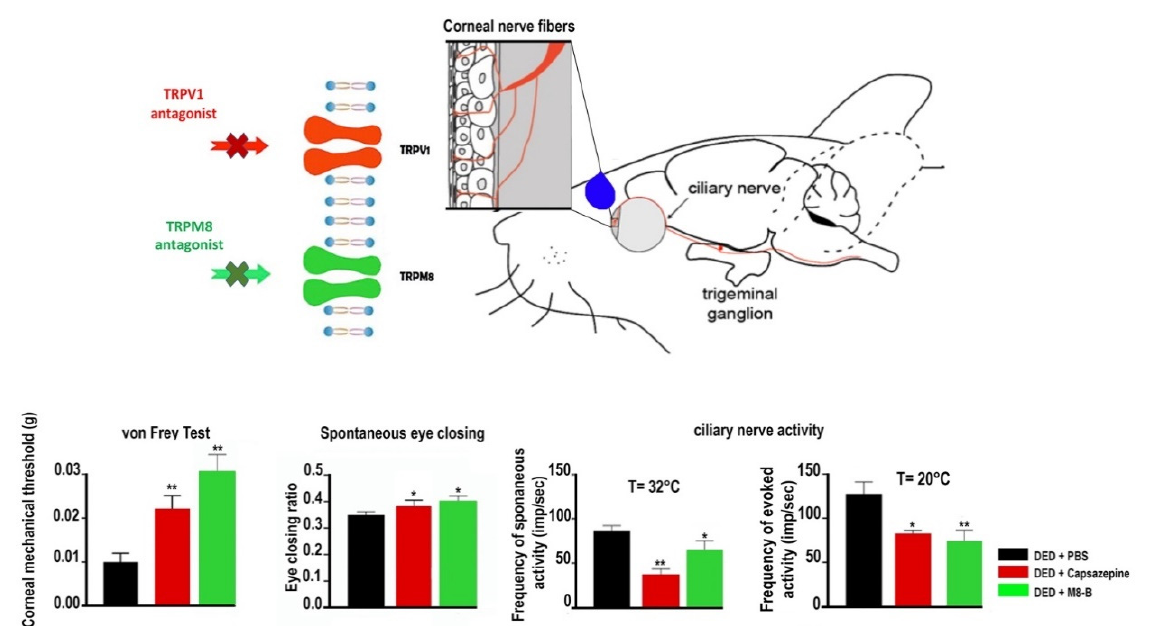
Figure 4. Mechanical allodynia, eye closing ratio of DED animals treated (twice daily from day 7 to day 21 after lacrimal gland excisions) with PBS, 10 µ M capsazepine, or 20 µ m M8-B. Corneal mechanical sensitivity measured with von Frey filaments. Quantification of the spontaneous eye closing ratio calculated by measuring the width/height ratio. Ex vivo evaluation of spontaneous and evoked activity of the ciliary nerve in DED mice treated (twice daily from day 7 to day 21 after lacrimal gland excisions) with PBS, 10 µ M capsazepine, or 20 µ m M8-B. Histograms show a mean value of spontaneous activity of the ciliary nerve at 32 ◦ C and evoked activity of the ciliary nerve at 20 ◦ C in DED mice. All experiments were conducted at day 21. * p < 0.05 and ** p < 0.01 relative to DED mice treated with PBS. Results are expressed as mean ± SEM. Images and bar charts adapted from [105].